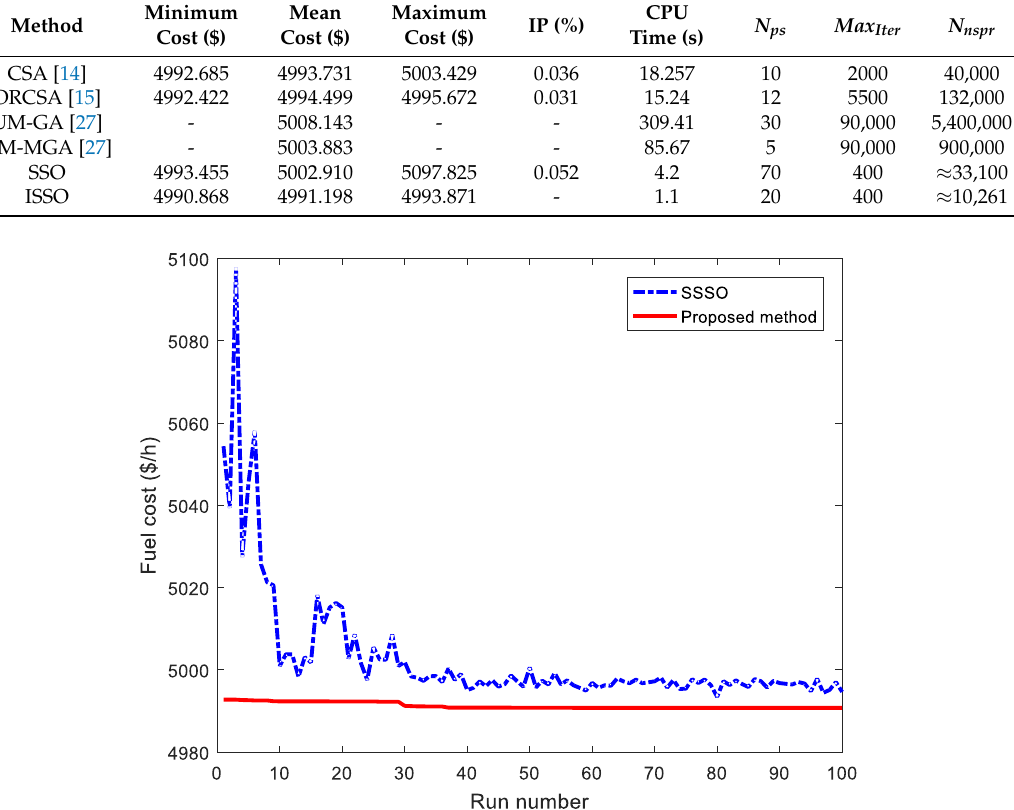
Figure 7. The best fitness functions of 100 runs obtained by SSSO and ISSO for system 4.